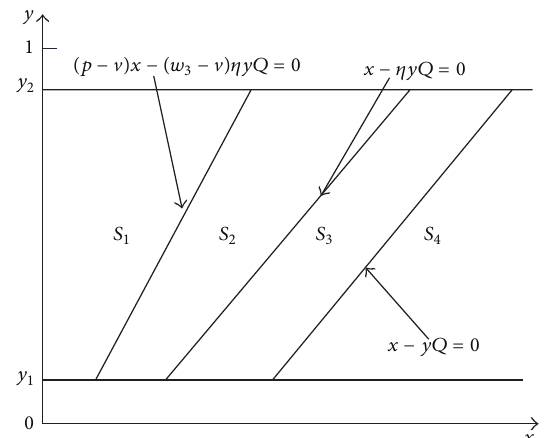
Figure 2: A graphical presentation of the demand and the yield rate under a QF